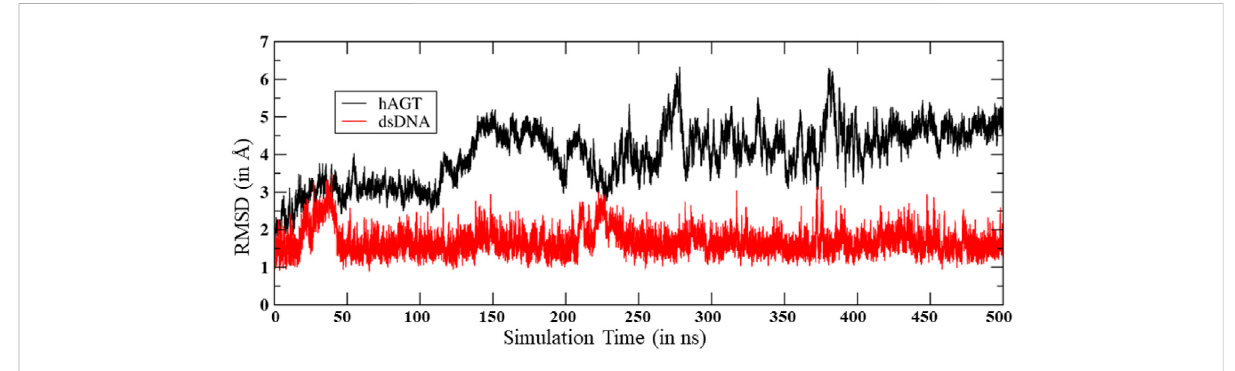
FIGURE 2 RMS deviation for hAGT and dsDNA during the MD